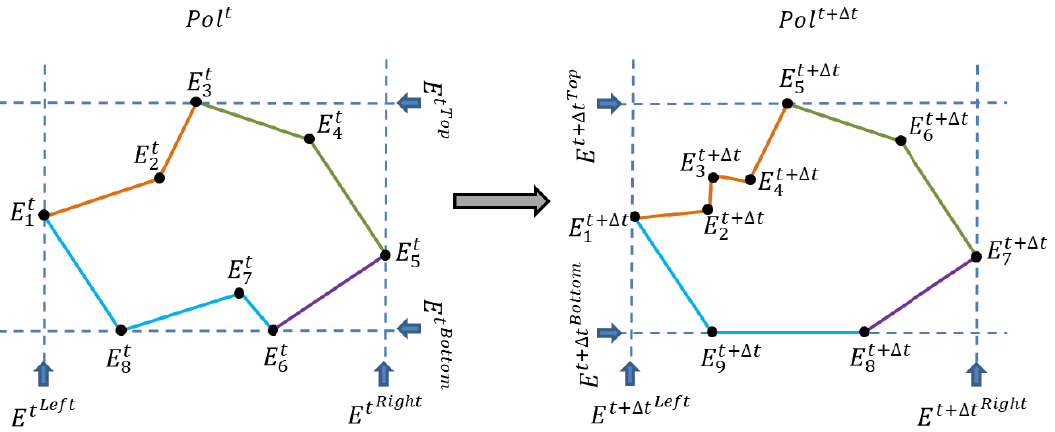
Figure 3. Decomposition of boundaries into four parts (marked by different colors) for the actual polygon Pol t and the next (forecasted) one Pol t +Δ t .